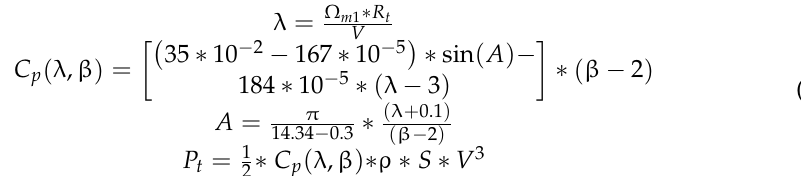
where V is the wind speed in [m/s]; β is the wedging angle of the blades; ρ is the air den- sity;   is the radius of the wind turbine; S is the circular area swept by the turbine; and   is the turbine mechanical power.